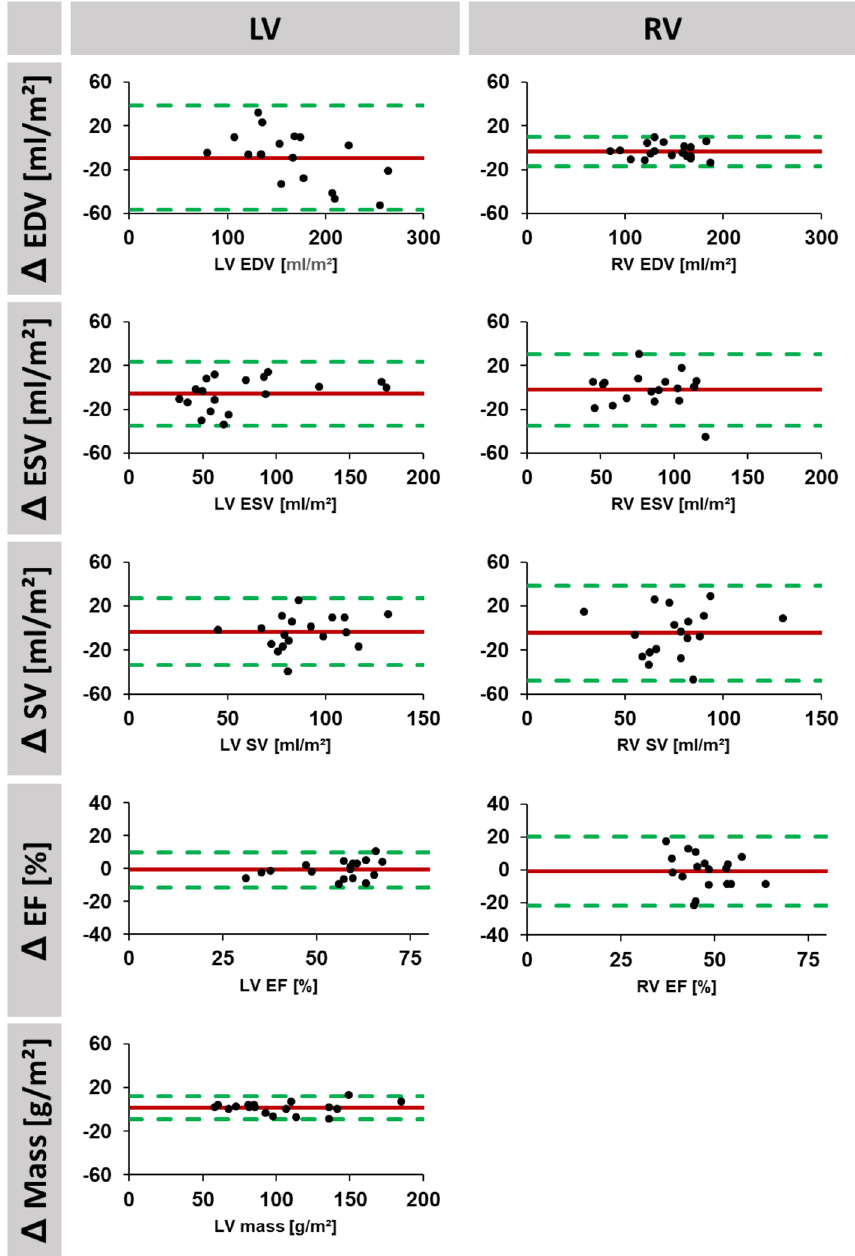
Figure 4. Agreement of short axis volume assessments based on the inexperienced observer. Bland Altman plots are shown for interstudy reproducibility of left (LV) and right (RV) ventricular end-diastolic (EDV) and -systolic (ESV) as well as corresponding stroke volume (SV) and ejection fraction (EF). LV assessments also included LV mass. (Δ = difference for interstudy measurements. Red: bias; green: limits of